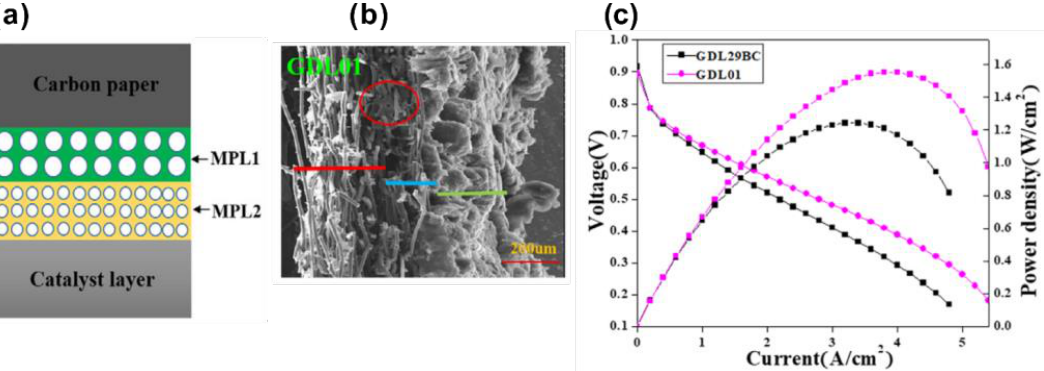
Figure 9. ( a ) A schematic diagram of the structure of the MPL with a gradient pore size (GDL01). ( b ) SEM images of MPLs without (GDL29BC) and with gradient pore size (GDL01). ( c ) I – V curves and power density of PEMFCs implemented with MPLs of GDL29BC and GDL01 performed under a relative humidity of 60%. Reproduced with permission [94]. Copyright 2020, John Wiley and Sons.